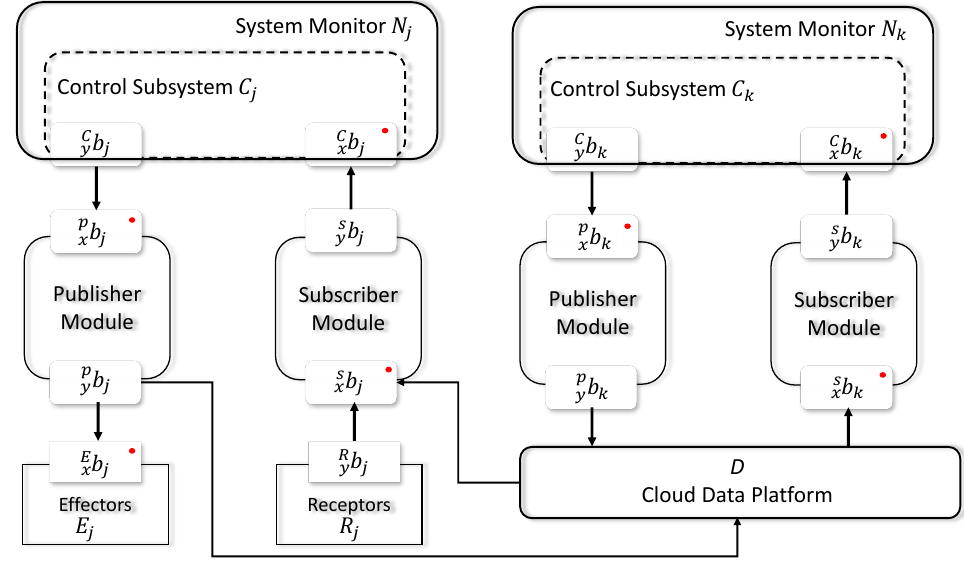
Figure 5. General structure IoT-aided robotic platforms with sample